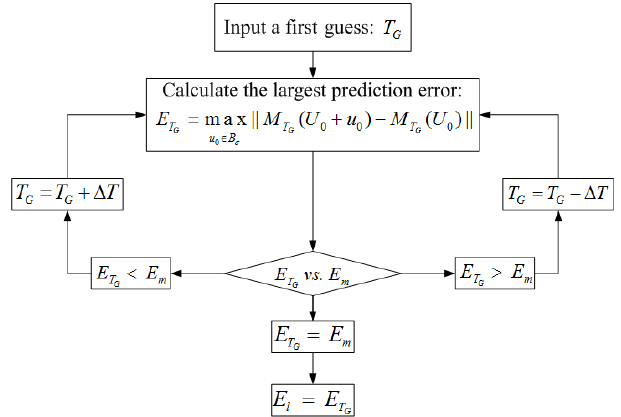
Figure 2. The distribution of solutions at the last 5000 steps when µ = 0 .